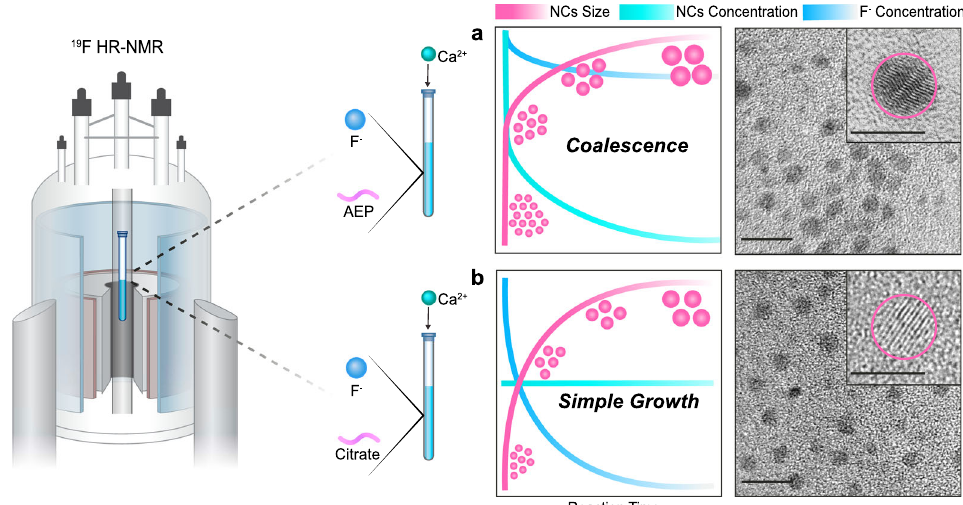
Fig. 5 Ligand effect on CaF 2 NC ’ s growth mechanisms and crystallographic properties. Schematic illustration of CaF 2 NC formation with different ligands; ( a ) AEP and ( b ) Citrate. The NCs ’ size (in pink), concentration (in turquoise) and F - ion concentration in solution (in blue). HR-TEM images of AEP-CaF 2 NCs presenting twinning defects (inset, in a ) and of Cit-CaF 2 NCs presenting a crystalline morphology (inset, in b